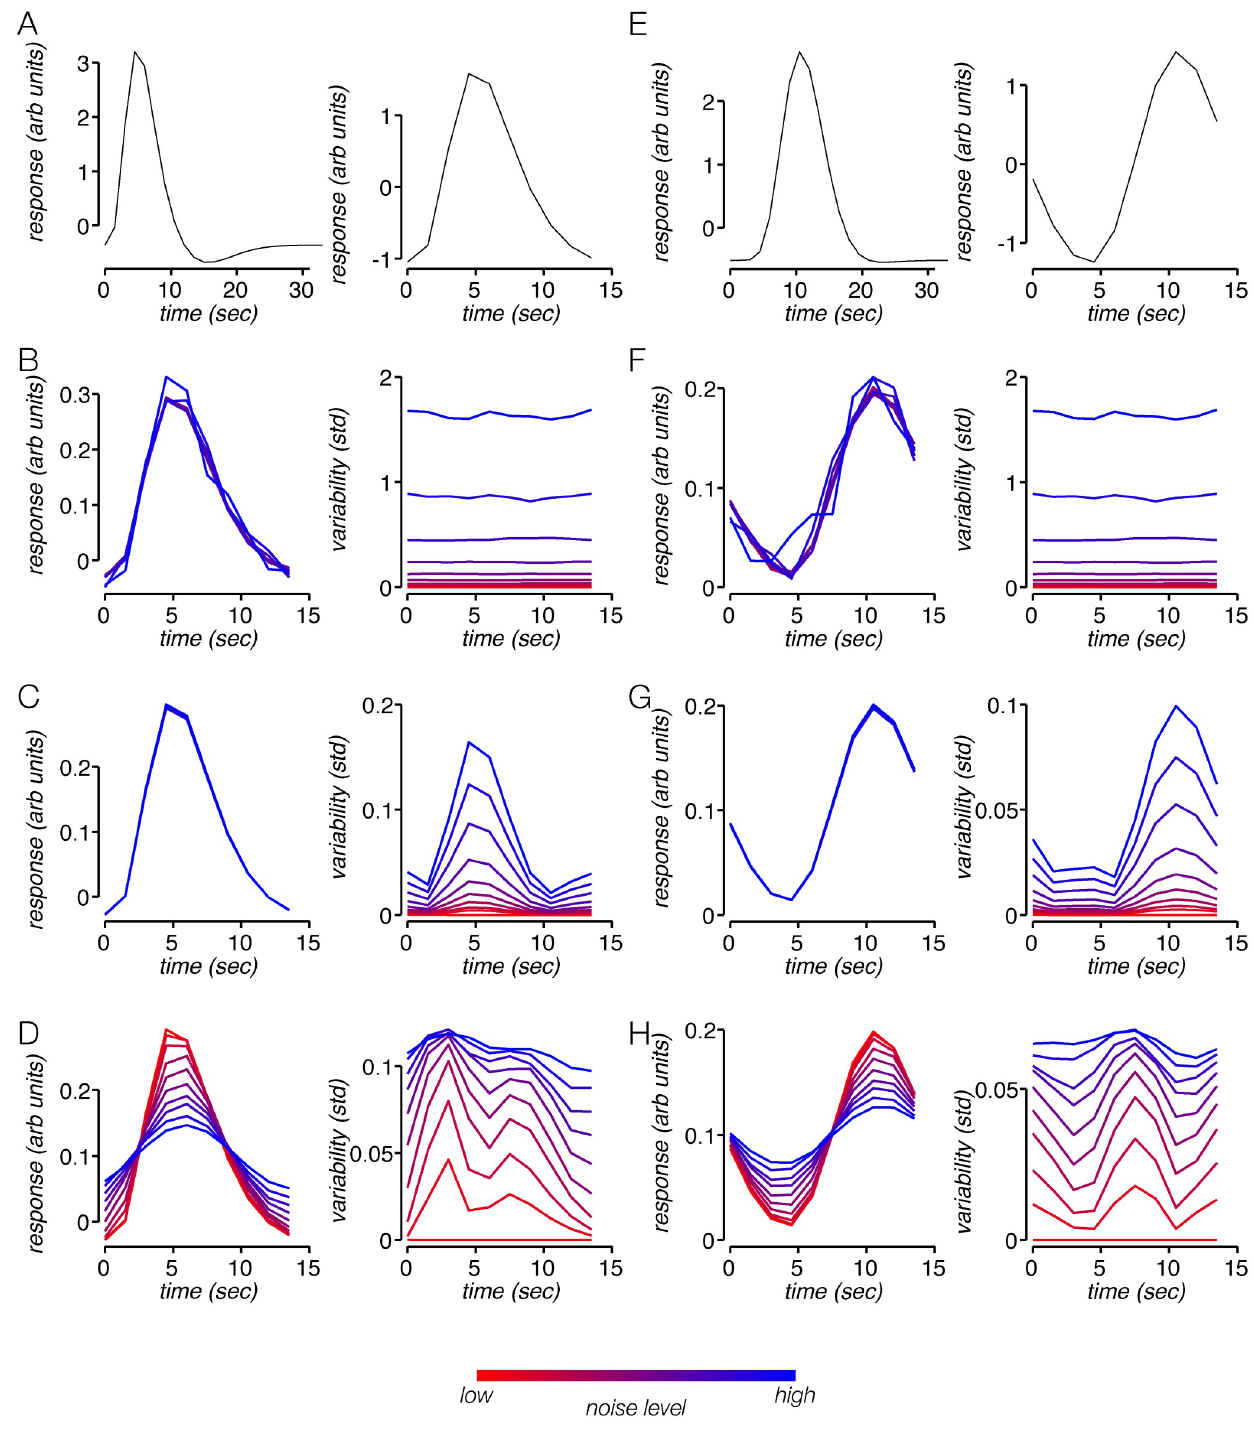
Fig 6. Impact of three distinct noise sources on measures of hemodynamic variability. (A) Left, IRF used for the first simulation. Right, average trial response with no noise. The response differs slightly from the IRF because the previous trial has a prolonged influence on the signal. (B) Left, average trials for independent noise ranging from minimal (red) to maximal (blue), for first simulation. Right, average time-point variability time course for the different independent noise levels. (C) Left, average trials for response amplitude jitter ranging from minimal (red) to maximal (blue). Right, average time-point variability for the different amplitude jitter levels. (D) Average trials for response temporal jitter ranging from minimal (red) to maximal (blue). Right, average time-point variability for the different temporal jitter levels. (E-H) Same as (A–D), for second simulation, using a different IRF. arb., arbitrary; IRF, impulse response function; std, standard